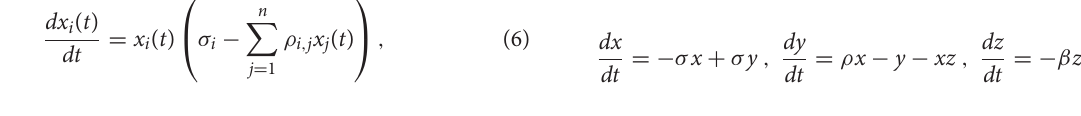
work, the outcomes of chi-square tests are visually represented as matrices A [ a i , j ], i , j 1 , . . . , N whose elements take = ∈ { }